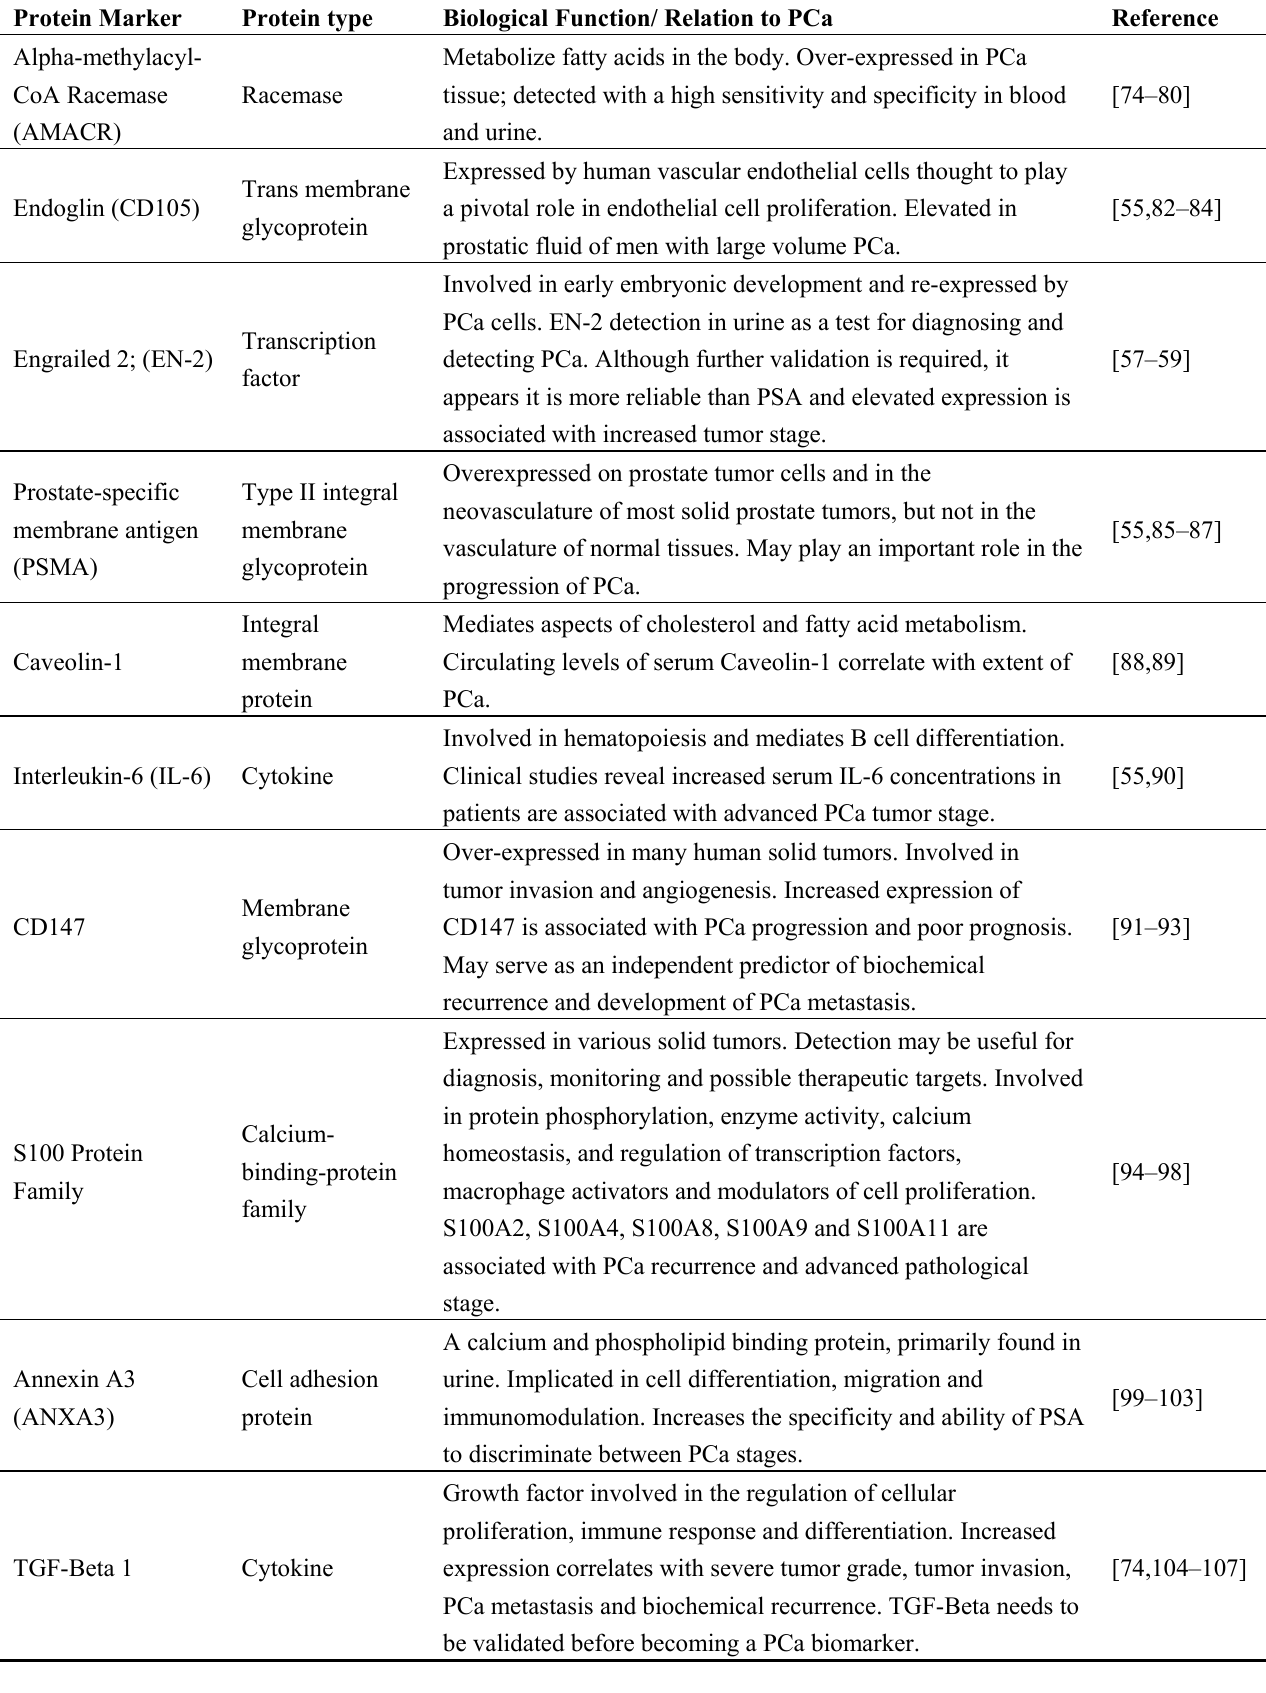
Table 2. Summary of current and emerging protein biomarkers for the diagnosis and prognosis of prostate